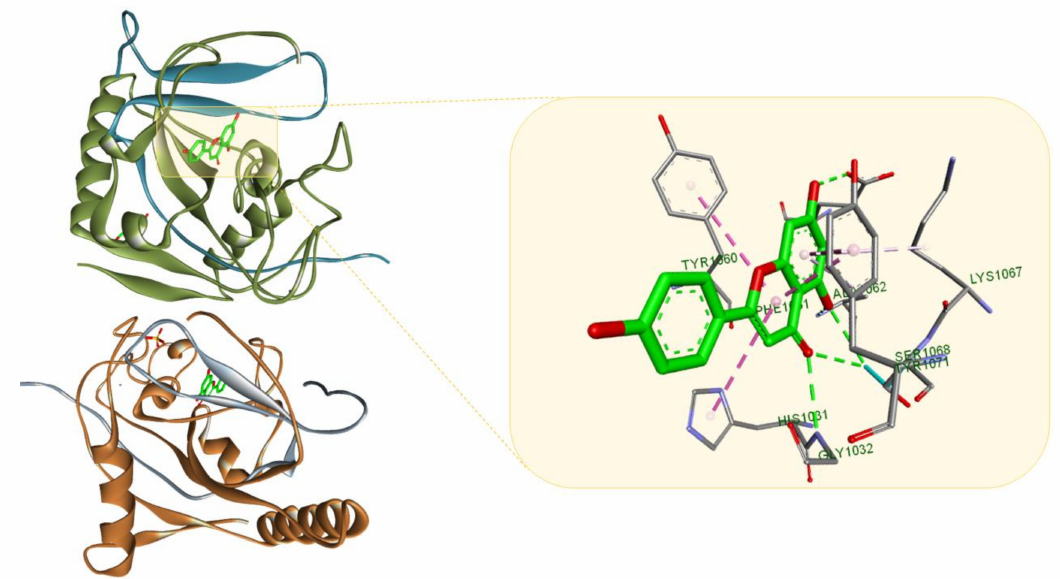
Figure 8. Apigenin (light green) in in complex with TNK2 (PDB ID: 4HKK); the flavone interacts with the surrounding amino acid residues through multiple HBs (green dotted lines) and several hydrophobic interactions (purple dotted lines). Protein-ligand representation was achieved using Biovia Discovery Studio 4.1 (Dassault